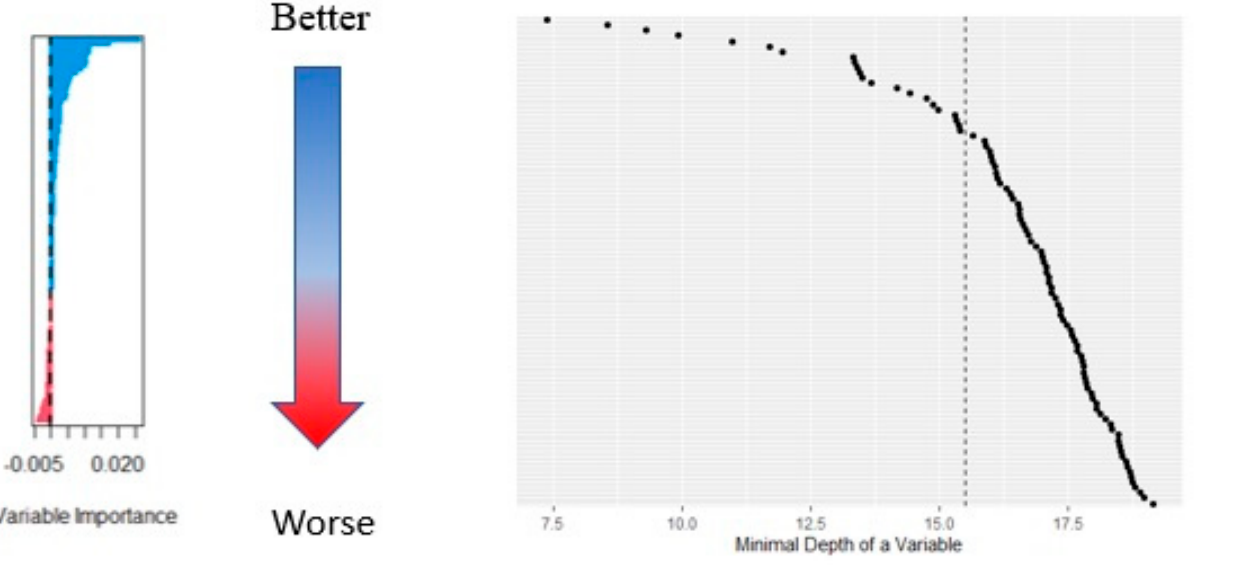
Figure 3. Relative importance of the radiomics features included in the study ( Left ), and the minimal depth of the variables in the random forest model (right).